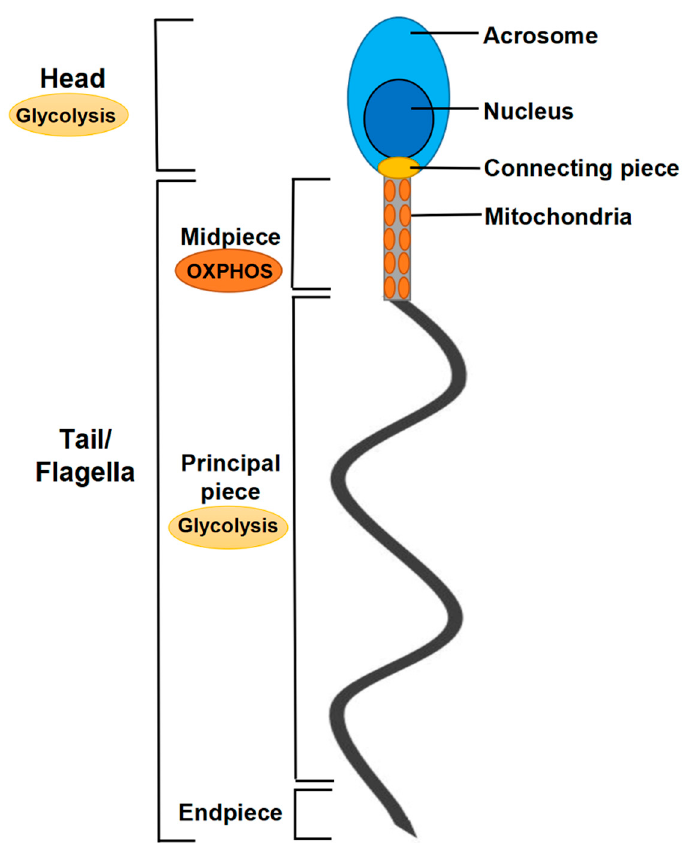
Figure 1. Schematic diagram of human sperm structure. The sperm head is composed of acrosome and nucleus, which is also the site of glycolysis. The tail/flagellum region contains connecting piece, midpiece, principal piece, and endpiece. Mitochondria are located in midpiece, which is the site of OXPHOS.